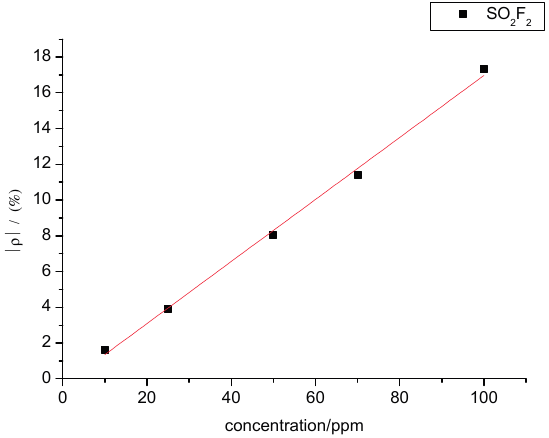
Figure 16. Linear relationship in the gas-sensing response of MWNT sensors to different concentrations of SO 2 F 2 .